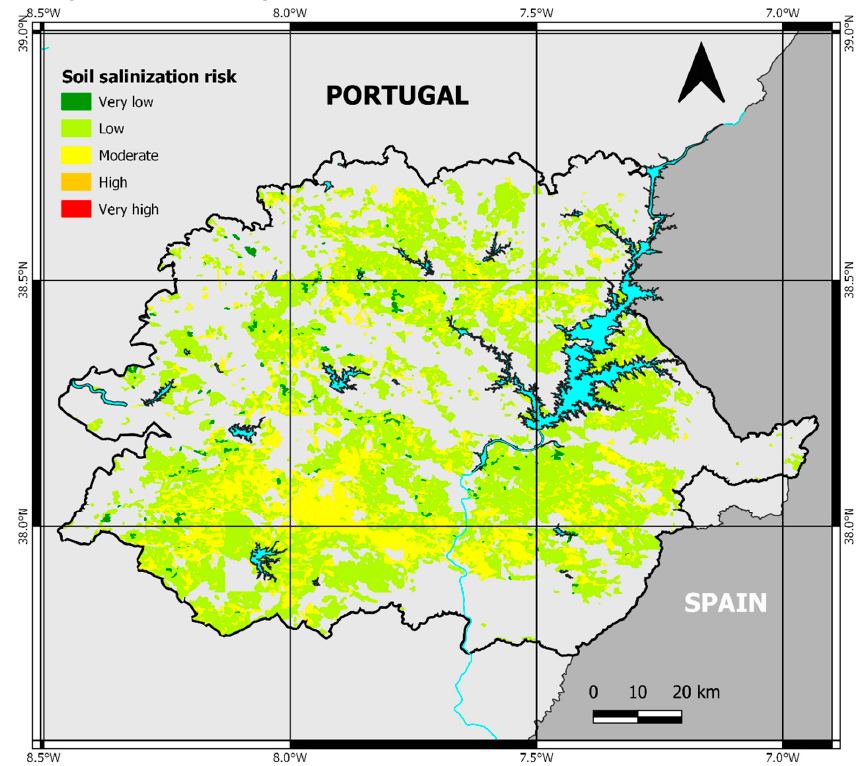
Figure 7. Salinization risk of the potentially irrigated area in the Inland Alentejo region based on the Salinization Risk index (RSA). Very Low risk: RSA < 7; Low risk: 7 ≤ RSA ≥ 10; Moderate risk: 11 ≤ RSA ≥ 14; High risk: 15 ≤ RSA ≥ 18; Very-High risk: RSA > 18. Moderate risk of salinization was predominantly related to low slope areas (Figure 8a).